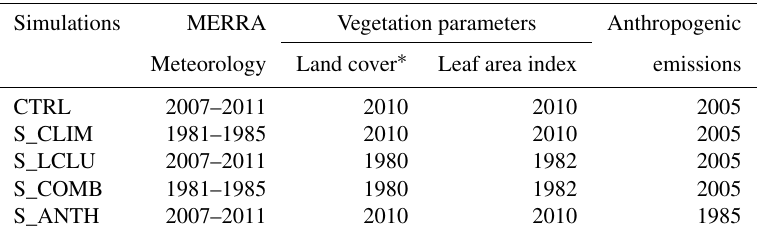
Table 1. Summary of the simulations conducted in this study.